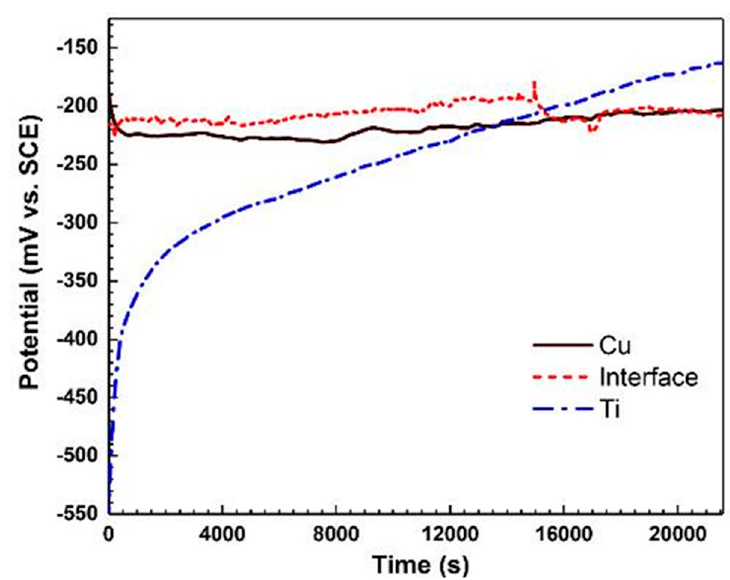
Figure 6. Open circuit potential versus time for Ti, Cu and weld interface in 3.5 wt.% NaCl solution for 6 h.